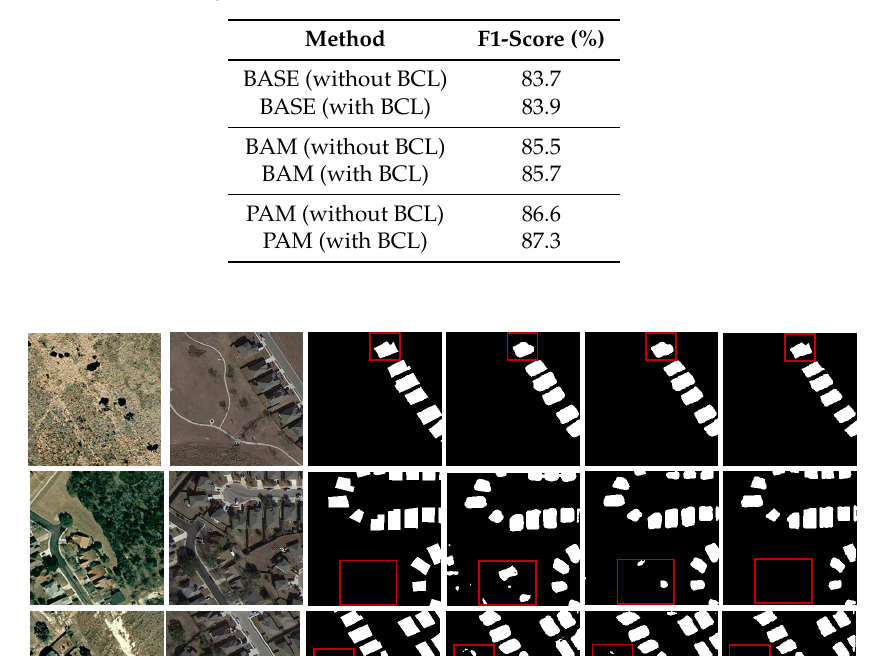
Table 5. Ablation study of batch-balanced contrastive loss (BCL) on LEVIR-CD test set.